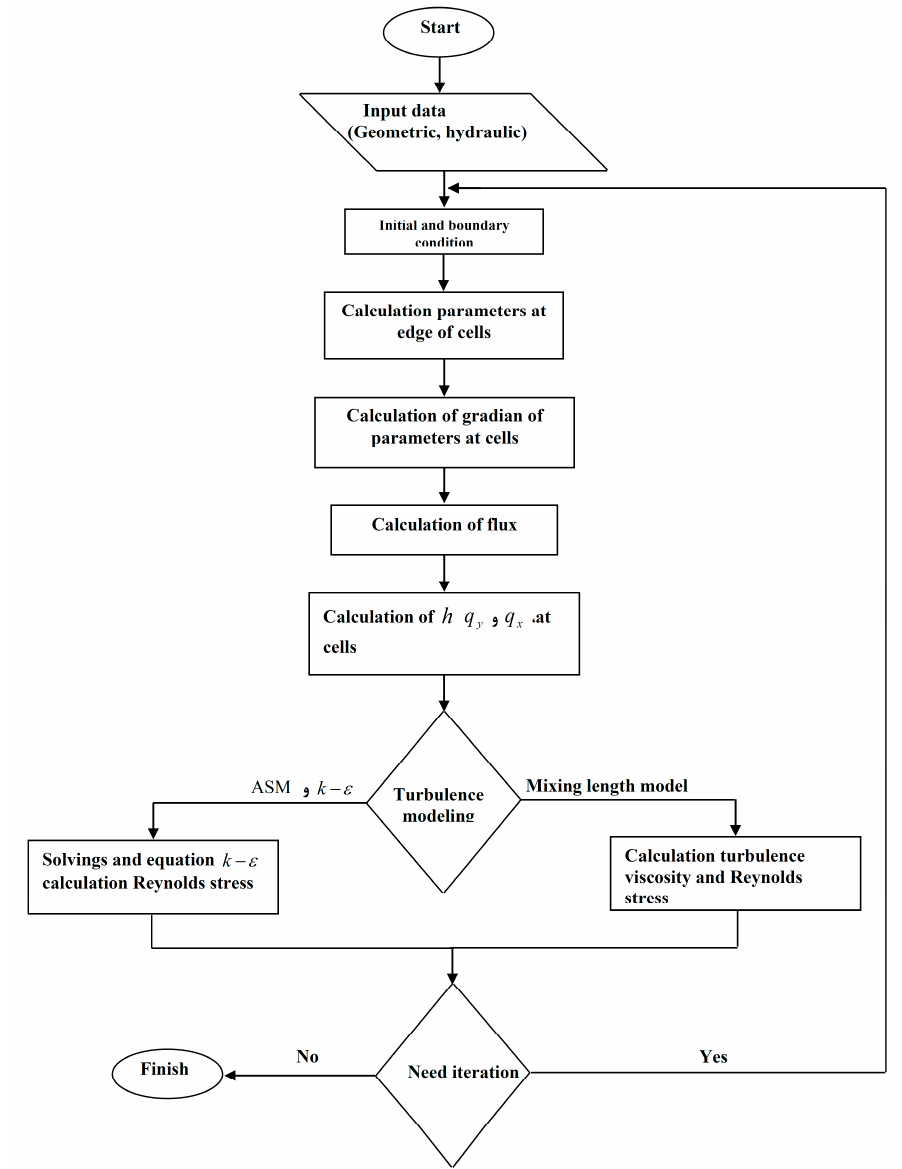
Figure 2. Flowchart of the written code.